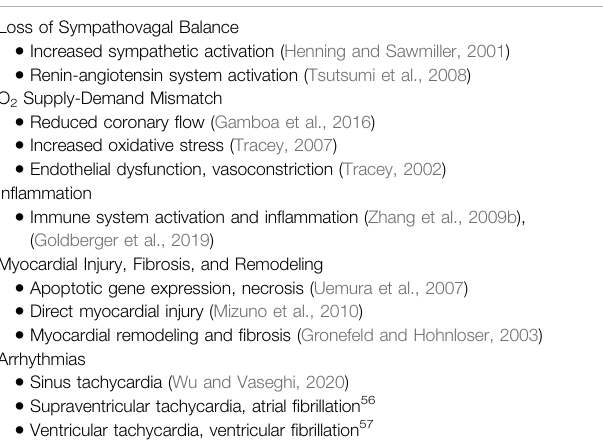
TABLE 1 | Summative biological effects of autonomic nervous system dysregulation. Loss of Sympathovagal Balance (cid:129) Increased sympathetic activation (Henning and Sawmiller,